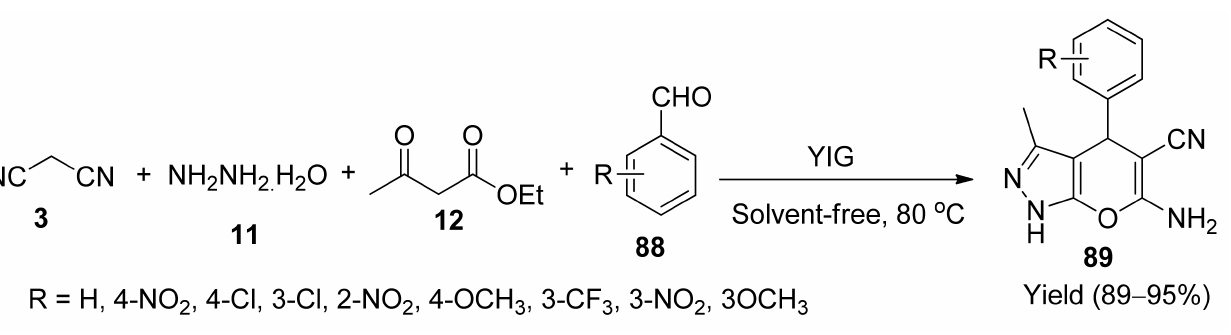
Scheme 26. Synthesis of pyranopyrazole derivatives 89 using Y 3 Fe 5 O 12